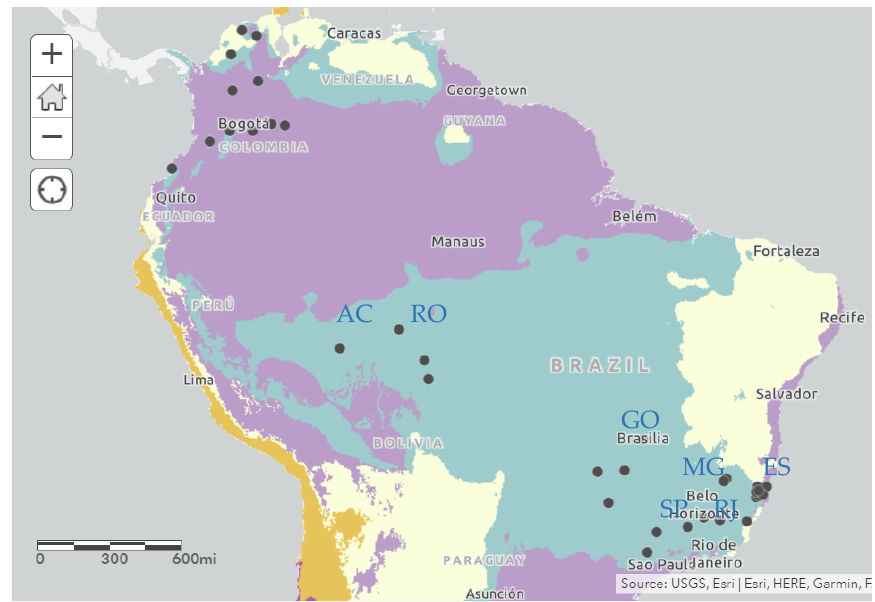
Figure 3. Map of South America comparing agro-ecologies of testing sites used in Brazil for breeding and those proposed for Colombia (all black dots). Brazilian sites are from a 2000 – 2022 search of publications and Colombian sites were those listed as adequate or ideal in the review by Campuzano-Duque et al. (2022) [10]. Two letter codes in blue text indicate the state in Brazil that are also listed in the text below.